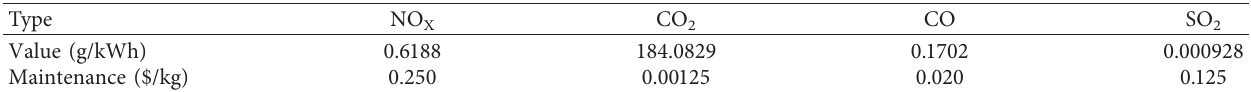
Table 9: Maintenance fee of pollutant